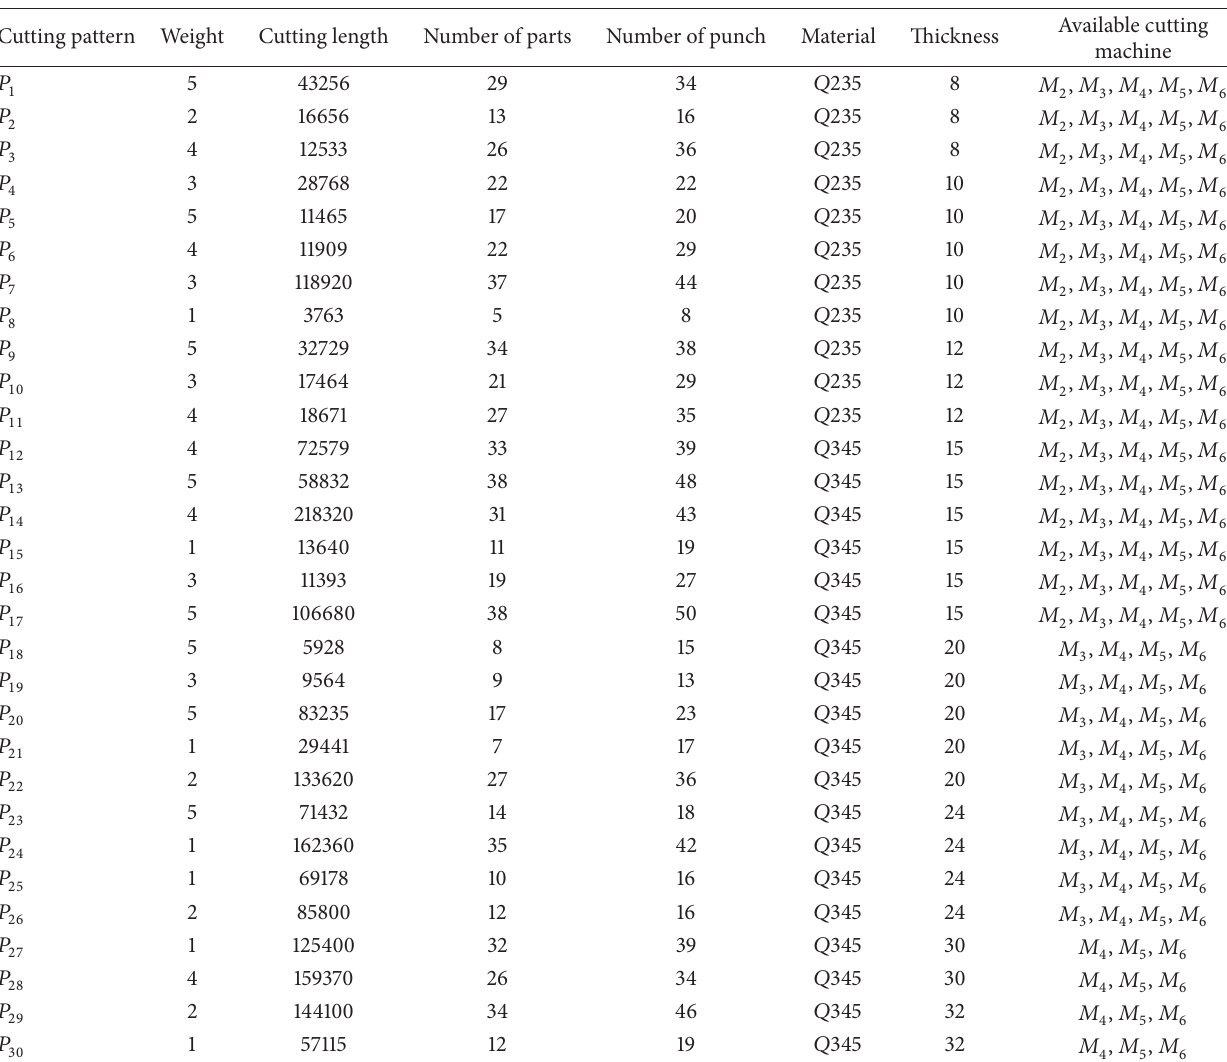
Table 2: The data of cutting patterns.